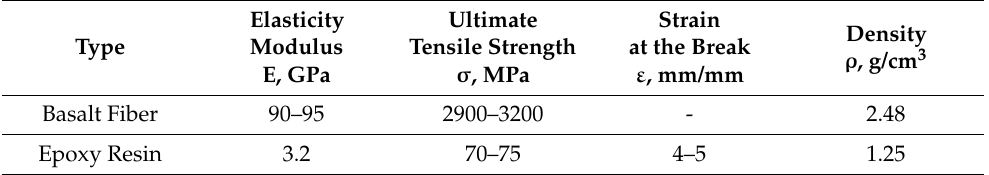
Table 1. Properties of resin and fiber used in the production of BFR/EP filament winding composite pipe.